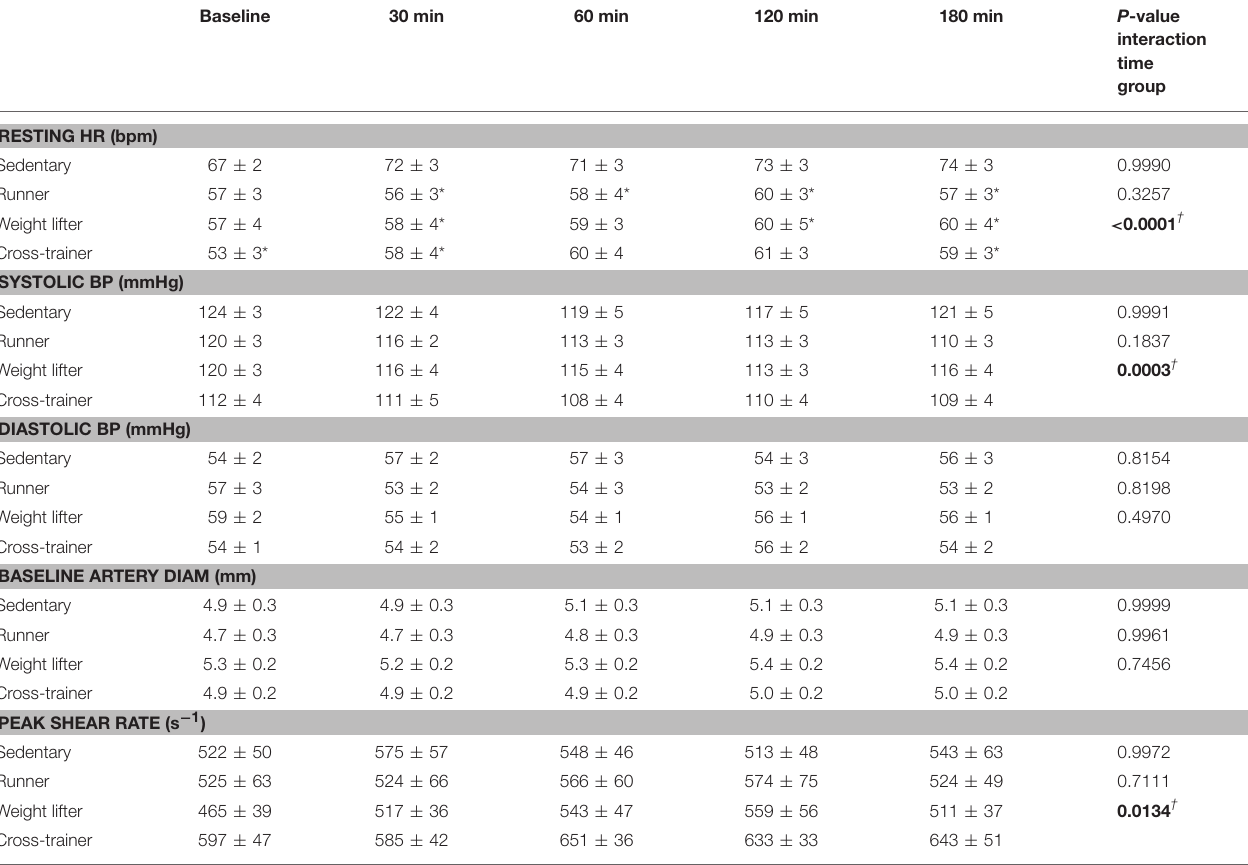
TABLE 2 | Data presented as mean ±